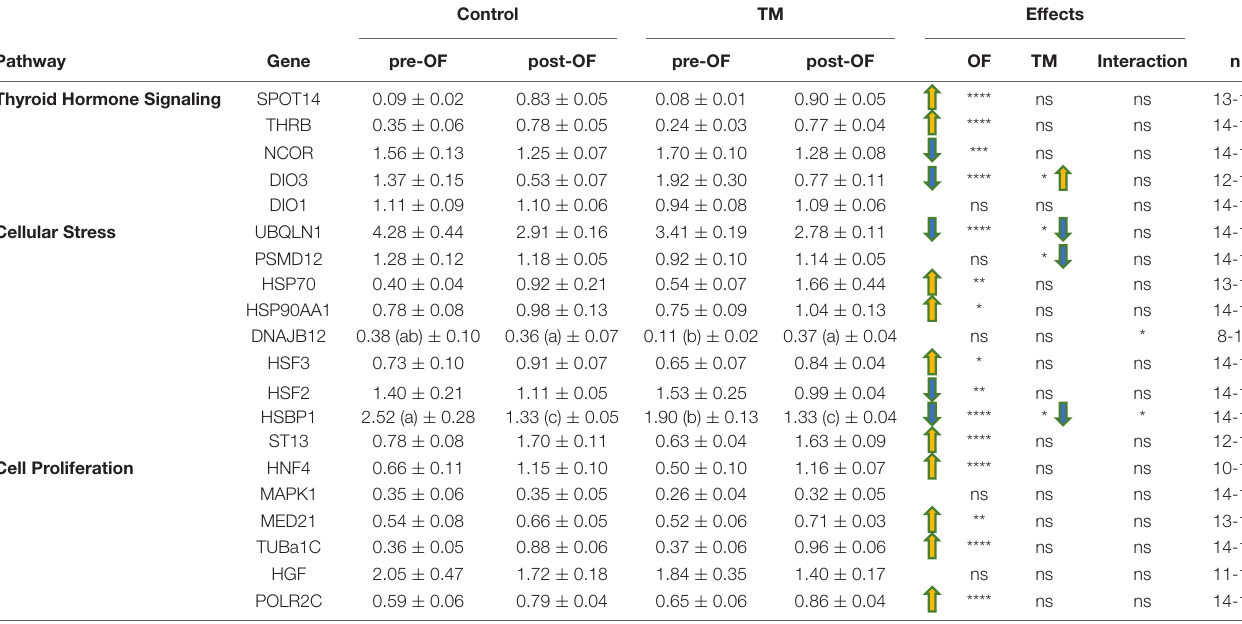
TABLE 2 | Hepatic relative expression of genes involved in the thyroid, stress and cell proliferation pathways depending on incubation conditions before and after